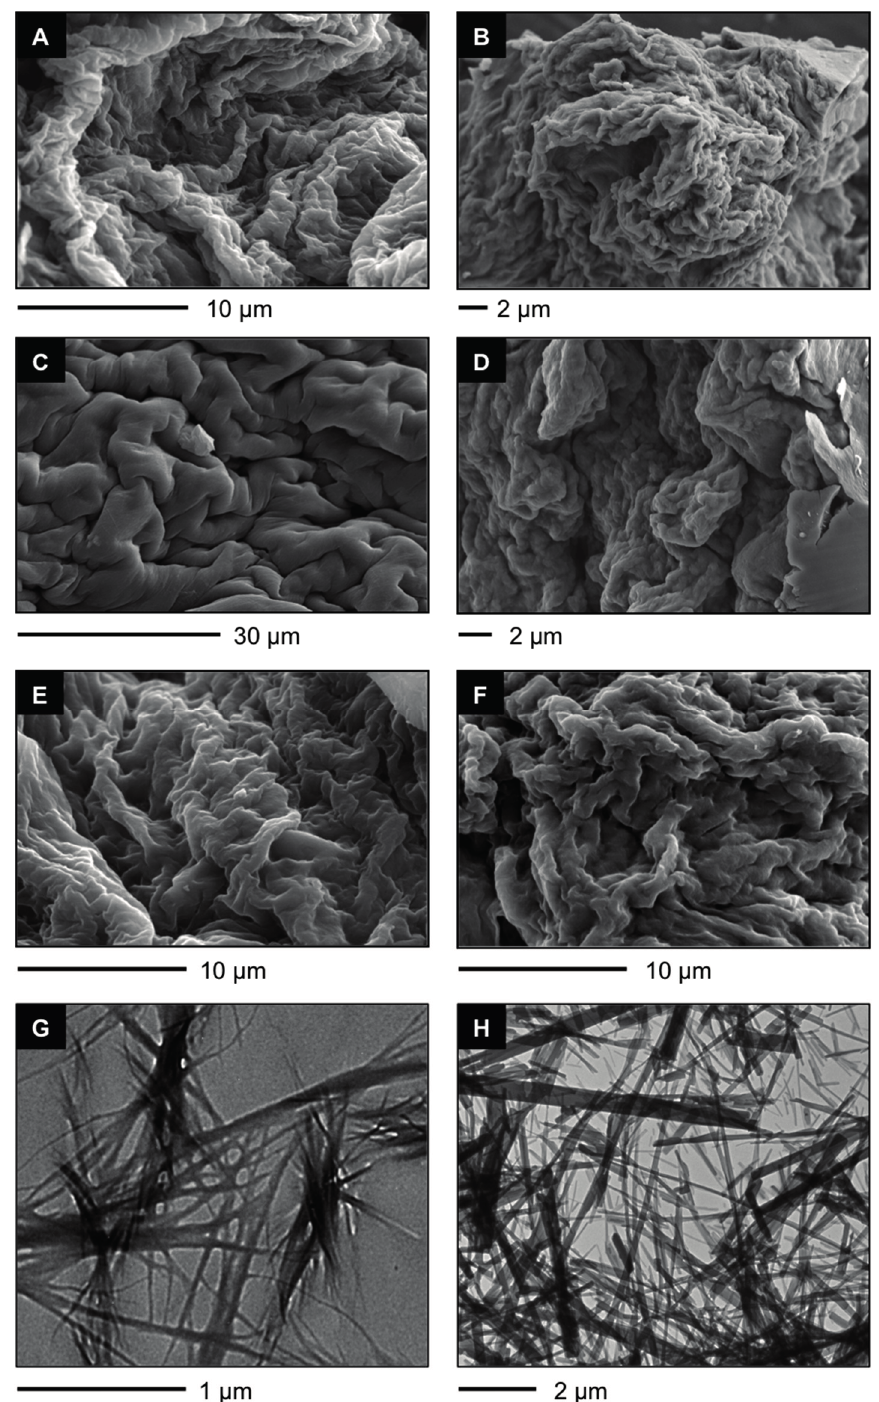
Figure 3. ( A – F ) Representative field emission scanning electron microscope (FESEM) images of xerogels prepared by freeze-drying the corresponding gel materials obtained at the minimum gelation concentration (MGC) as indicated in Table 1: ( A ) A4 in toluene (POP) [38]; ( B ) A4 in toluene (PSG); ( C ) F-A4 in toluene (POP) [38]; ( D ) F-A4 in toluene (PSG); ( E ) Bis-A4 in toluene (POP) [38]; ( F ) Bis-A4 in toluene (PSG); and ( G , H ) Representative transmission electron microscope (TEM) images of xerogels prepared by freeze-drying the corresponding gel materials obtained at the MGC as indicated in Table 1; ( G ) A4 in toluene (POP) [38]; ( H ) A4 in toluene